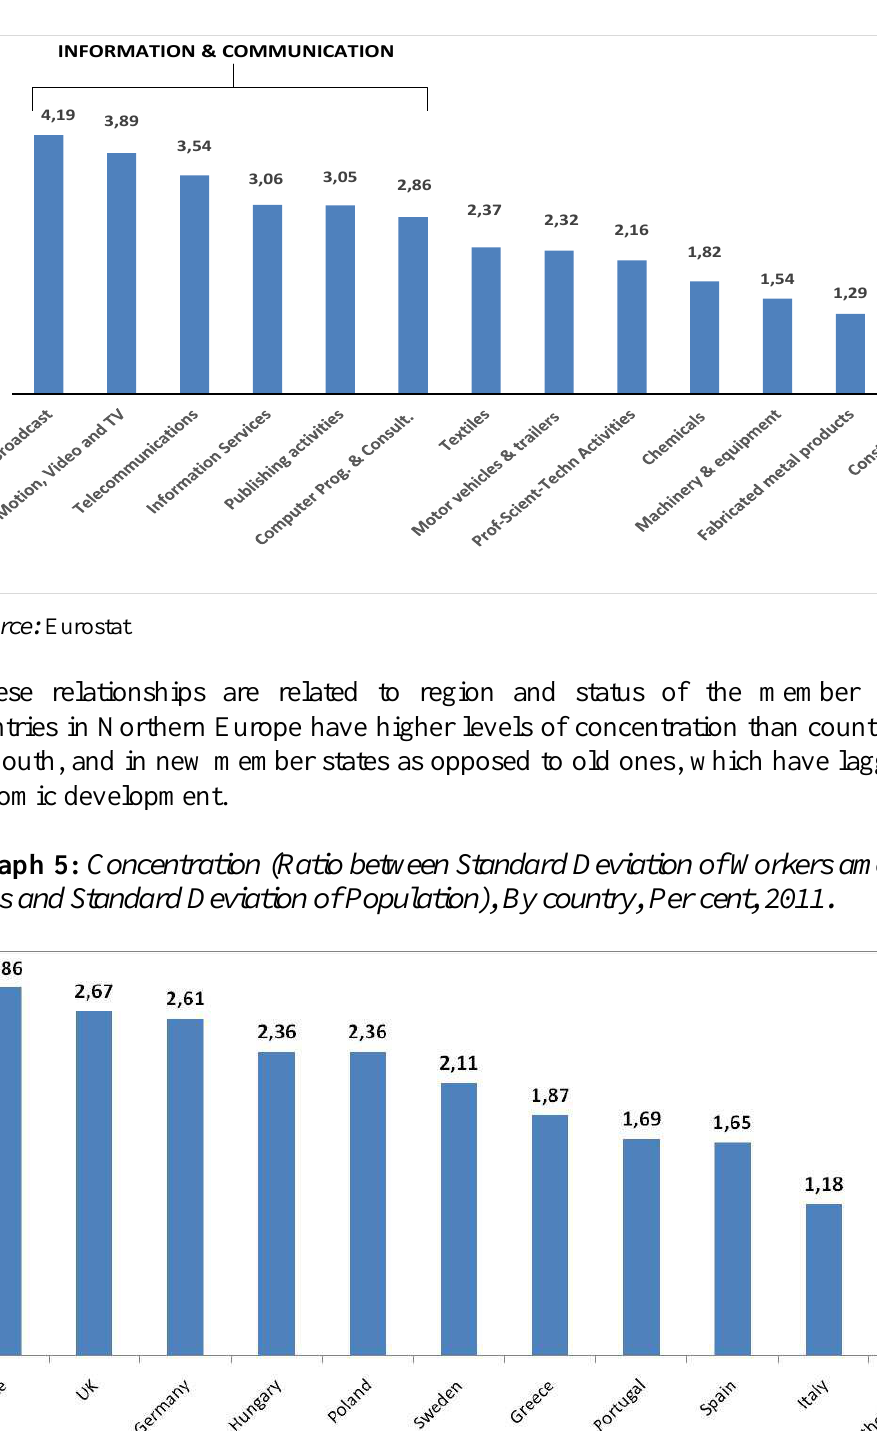
Graph 4: Concentration (Ratio between Standard Deviation of Workers amongst Areas and Standard Deviation of Population), By Sector, Per cent, 2011.